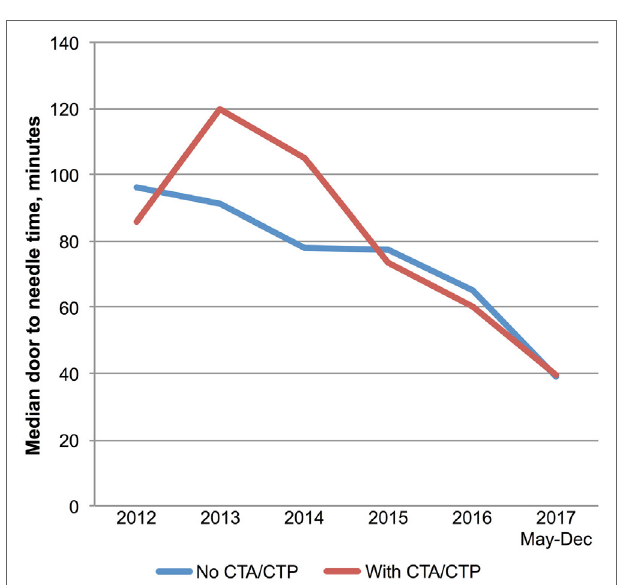
needle time for patients treated with ( n = 87) and without ( n = 147) prior multimodal imaging. Abbreviations: CTA, computed tomography angiogram; CTP, computer tomography perfusion.